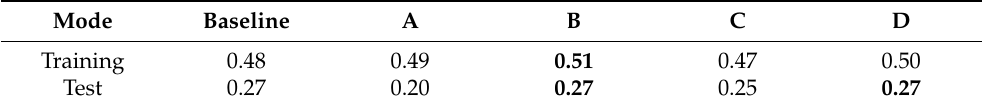
Table 21. Comparison results of mIoU scores for the respective Cityscapes experiments (Bold values show maximum scores).